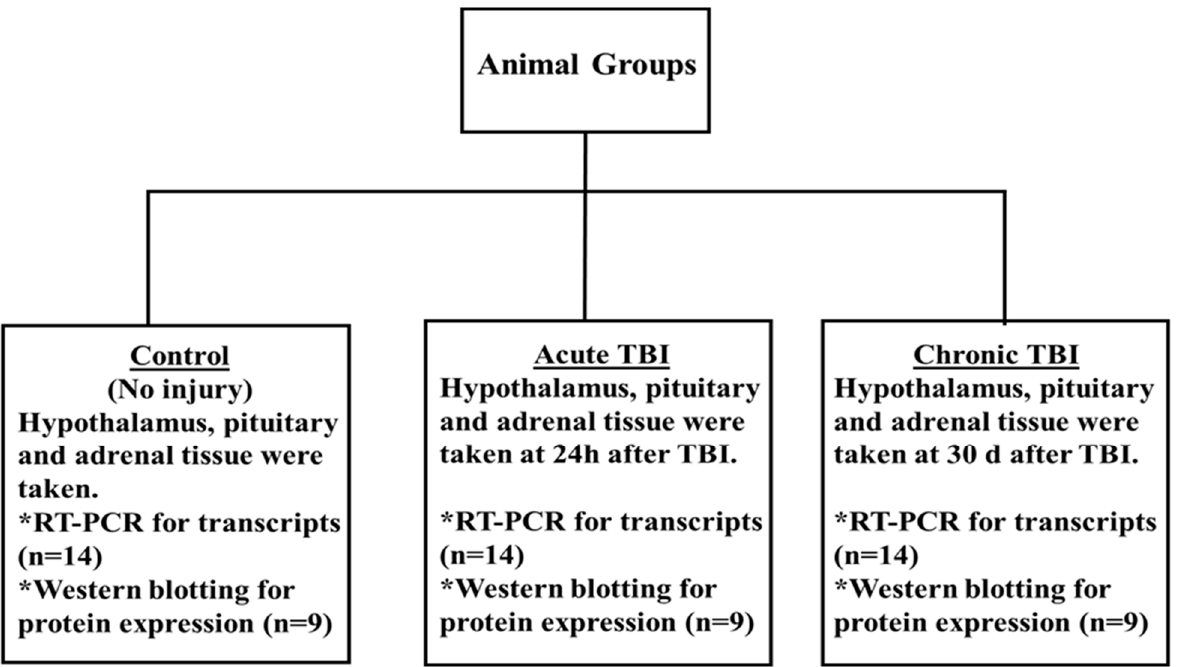
Figure 4. Experimental design. Anesthetized male rats were subjected to TBI with the CCI. The control group was sacrificed directly without any operation. The acute TBI group was sacrificed at 24 h after TBI with CCI. The chronic TBI group animals were sacrificed 30 days after TBI with CCI. The hypothalamus, pituitary, and adrenals were taken from each group. mRNA expression analyses were performed on 14 rats for each group. Western blot analyses were performed on nine rats for each group. All of the findings were derived from the entire total tissue of the hypothalamus, pituitary, and adrenals. All PCR and Western blot analyses for detecting transcript and protein levels were repeated at least twice independently and blindly.